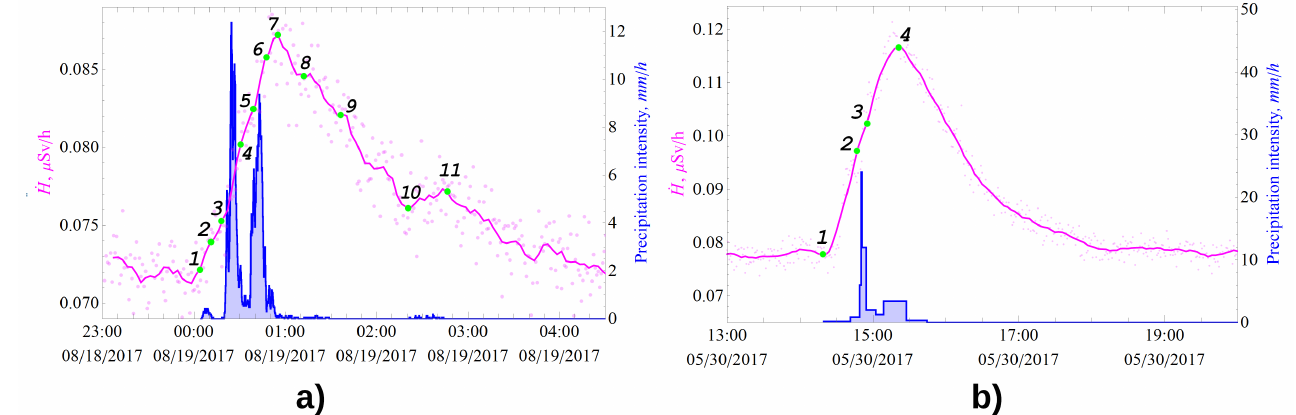
Figure 2. Analysis of γ -background dynamics during type III precipitation of ( a ) 18 August ( b ) 30 May (occurred at IMCES, Tomsk,